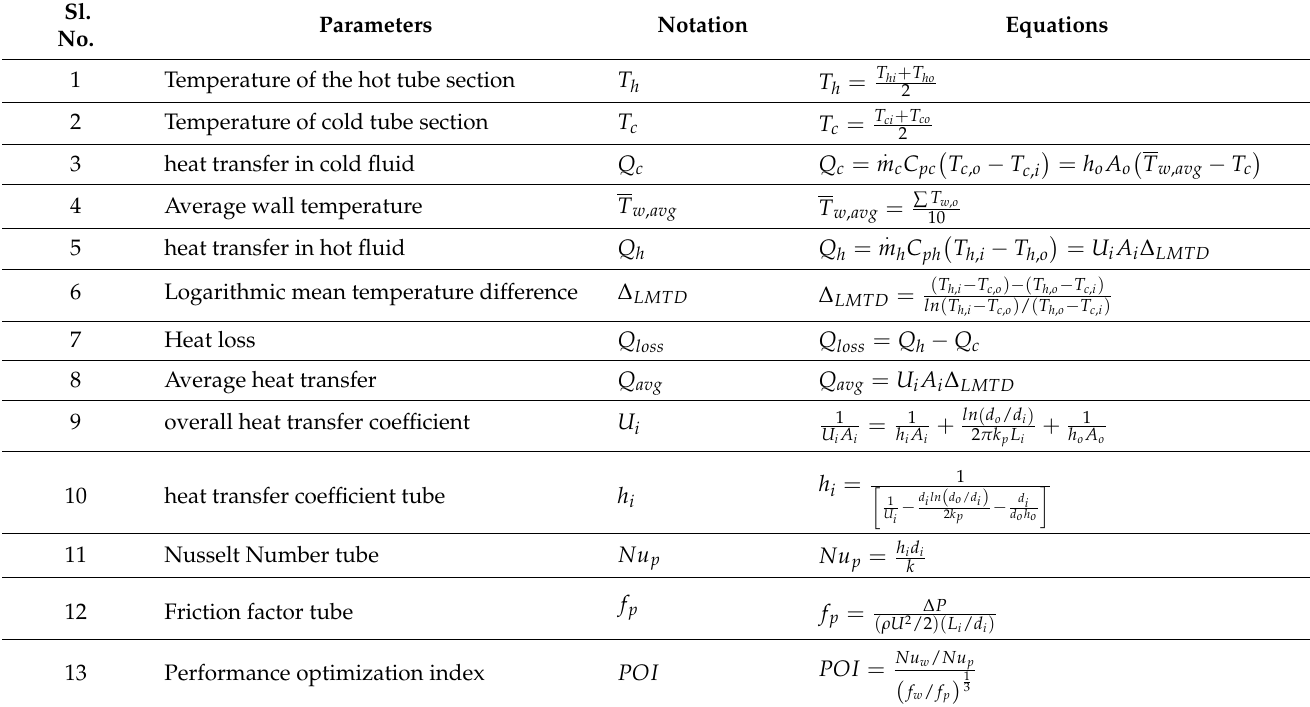
Table 3. Numerical and Experimental Correlations.